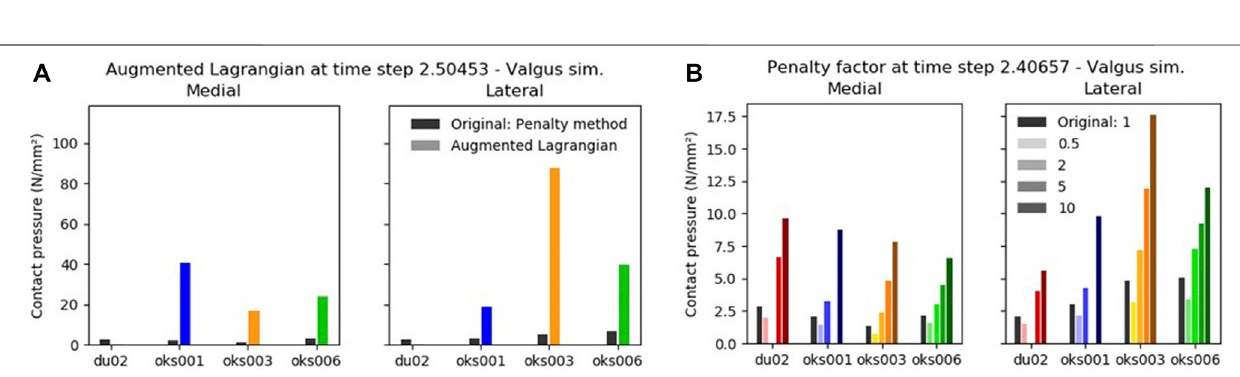
FIGURE 9 | The in fl uence of the Augmented Lagrangian (A) and Penalty factor (B) on the peak contact pressure in valgus rotation.